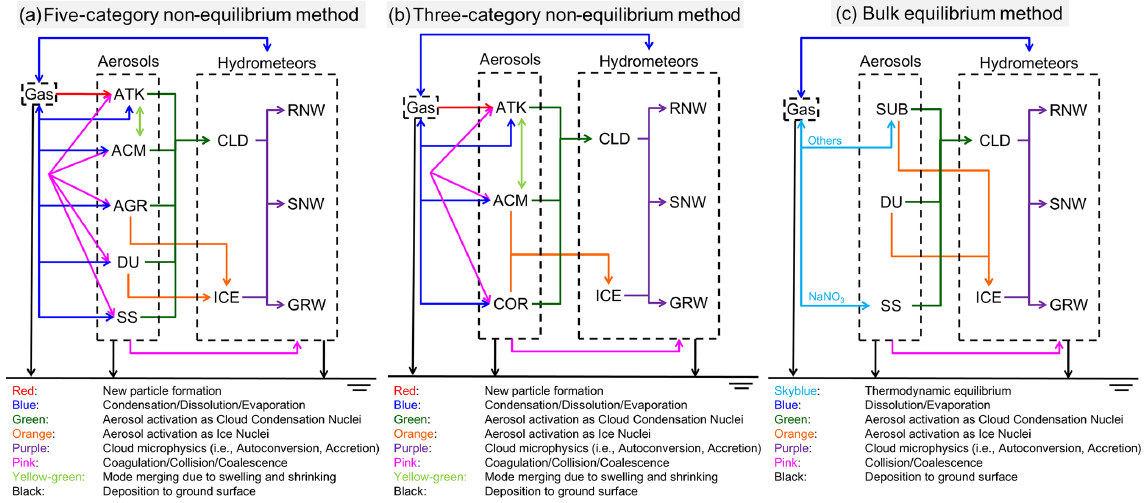
Figure 1. Schematic illustrations of gas–aerosol–cloud dynamic processes considered in (a) five-category, (b) three-category (global stan- dard), and (c) bulk equilibrium methods. ATK (Aitken mode), ACM (soot-free accumulation mode, five-category; accumulation mode, three- category), AGR (accumulation mode, mixed with soot aggregate) DU (mixture with dust; both mineral and anthropogenic dust), SS (mixture with sea salt), COR (coarse mode), SUB (submicron), CLD (cloud), ICE (cloud ice), RNW (rain), SNW (snow), and GRW (graupel). This figure is same as Fig. 1 of Kajino et al.